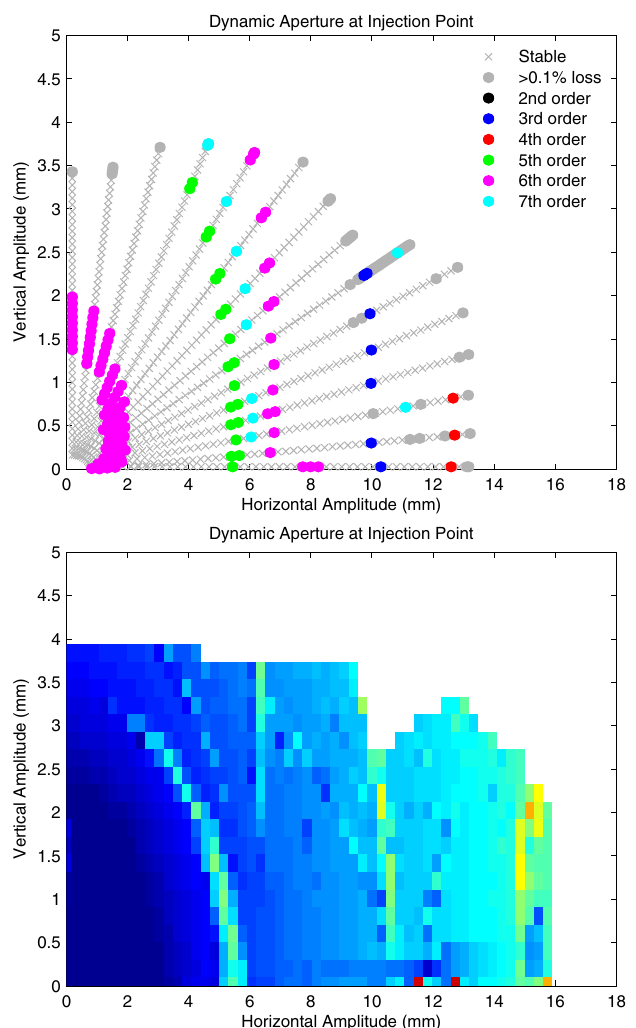
FIG. 5. Dynamic aperture and resonance lines plotted in the ð x; y Þ plane: measured (top) and model (bottom). The color coding of the points corresponds to that of Figs. 2 and 4.